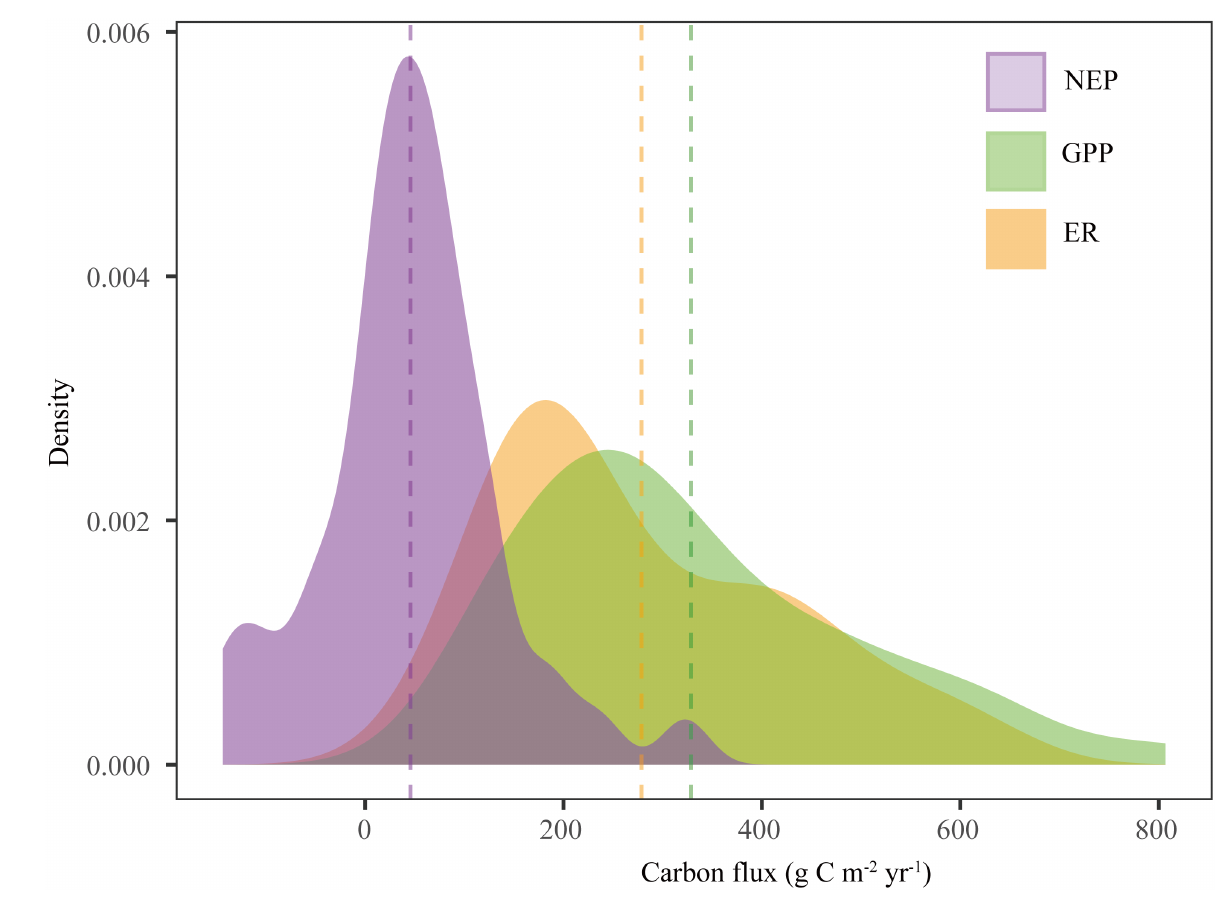
FIGURE 3 Density distributions of carbon fl uxes (GPP, ER, and NEP) in Chinese drylands. The dotted lines represent the mean values of carbon fl uxes. NEP, net ecosystem productivity; GPP, gross primary productivity; ER, ecosystem